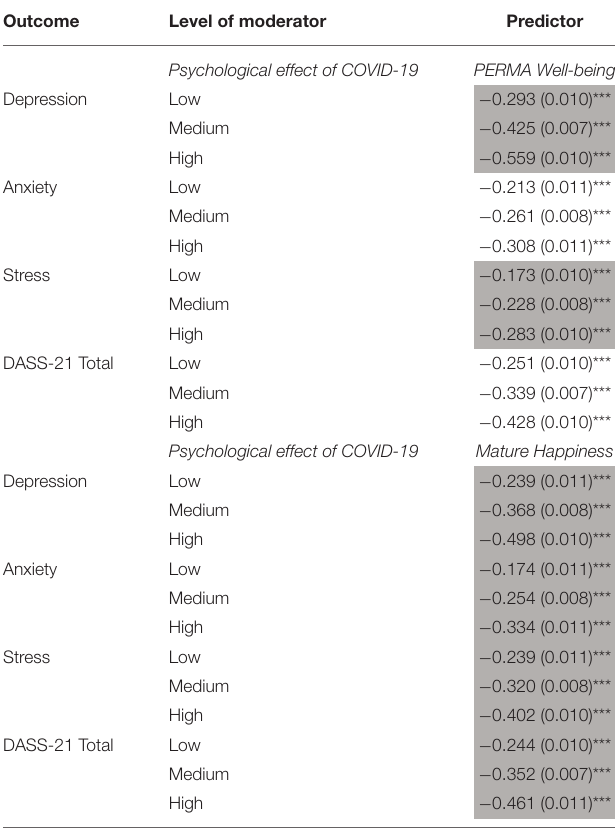
TABLE 5 | Multilevel modeling predicting markers of psychological